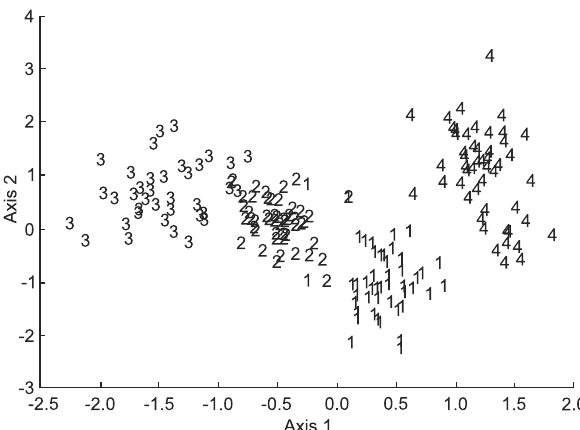
Figure 1. Ordination diagram from two principal components on ecomorphological attributes of four studied species: (1) A. cf. bimacu- latus ; (2) A. parahybae ; (3) O. hepsetus ; (4) M. maculatus .